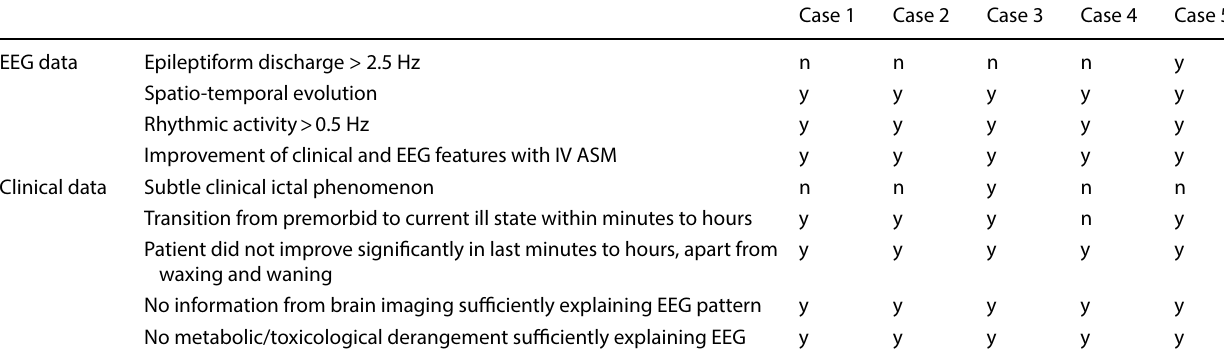
Table 3 Five NCSE patients’ EEG and clinical data reviewed by modified Salzburg Consensus Criteria for